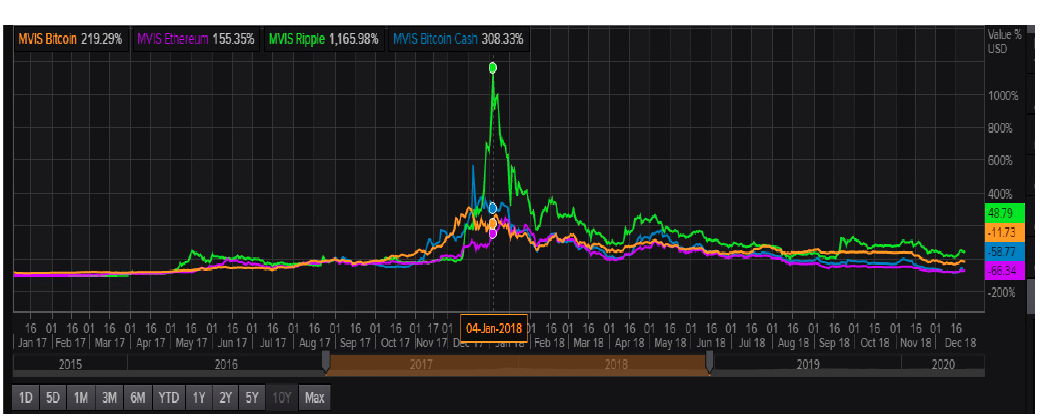
Figure 4. The evolution of worldwide cryptocurrencies, 2012–2020. Source: Authors’ own processing based on Thomson Reuters data.